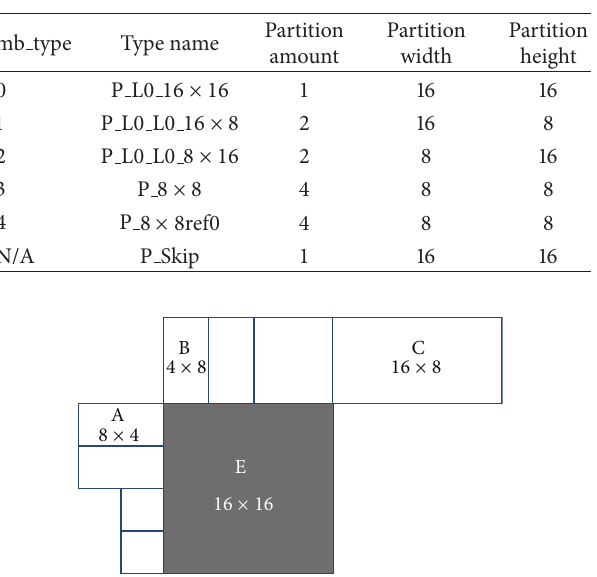
Figure 6: Current block and adjacent blocks with subpartitions.